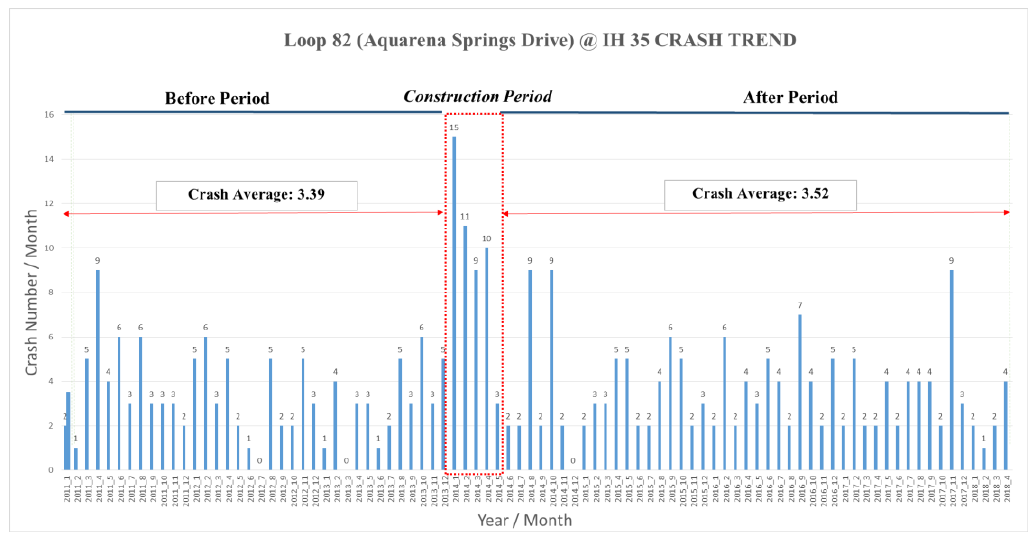
Figure 3. Monthly crash frequency during the study period (January 2011 – April 2018) at Intersection 1 on Loop 82 (Aquarena Springs Drive) at (Interstate Highway) IH 35.